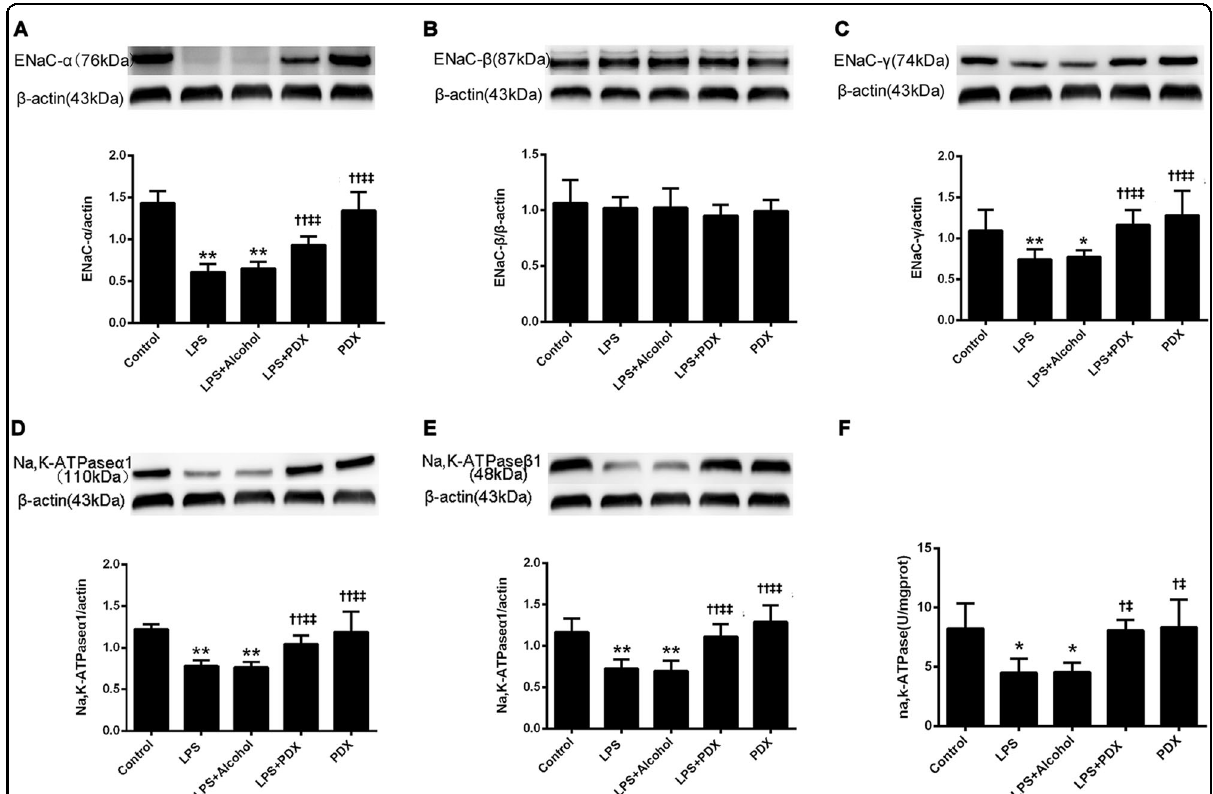
Fig. 3 Protectin DX enhanced sodium channel and Na, K-ATPase expression and Na, K-ATPase activity in LPS-induced acute lung injury in vivo. Protectin DX (5 µg/kg) was injected into the caudal veins of Sprague-Dawley rats 8 h after LPS (14 mg/kg) stimulation; the rats were ventilated for 60 min, and the right lung tissues were harvested to measure the protein expression levels of the sodium channel α , β , and γ subunits ( a , b , c ) and Na, K-ATPase α 1 and β 1 subunits ( d , e ) by western blotting. In addition, the Na, K-ATPase activity in the lung tissue homogenates was detected by kits ( f ). The data are presented as the mean ± SD. n = 8. PDX protectin DX. Alcohol was the solvent for protectin DX. * p < 0.05, ** p < 0.01 versus the control group; † p < 0.05, †† p < 0.01 versus the LPS group; ‡ p < 0.05, ‡‡ p < 0.01 versus the LPS + alcohol